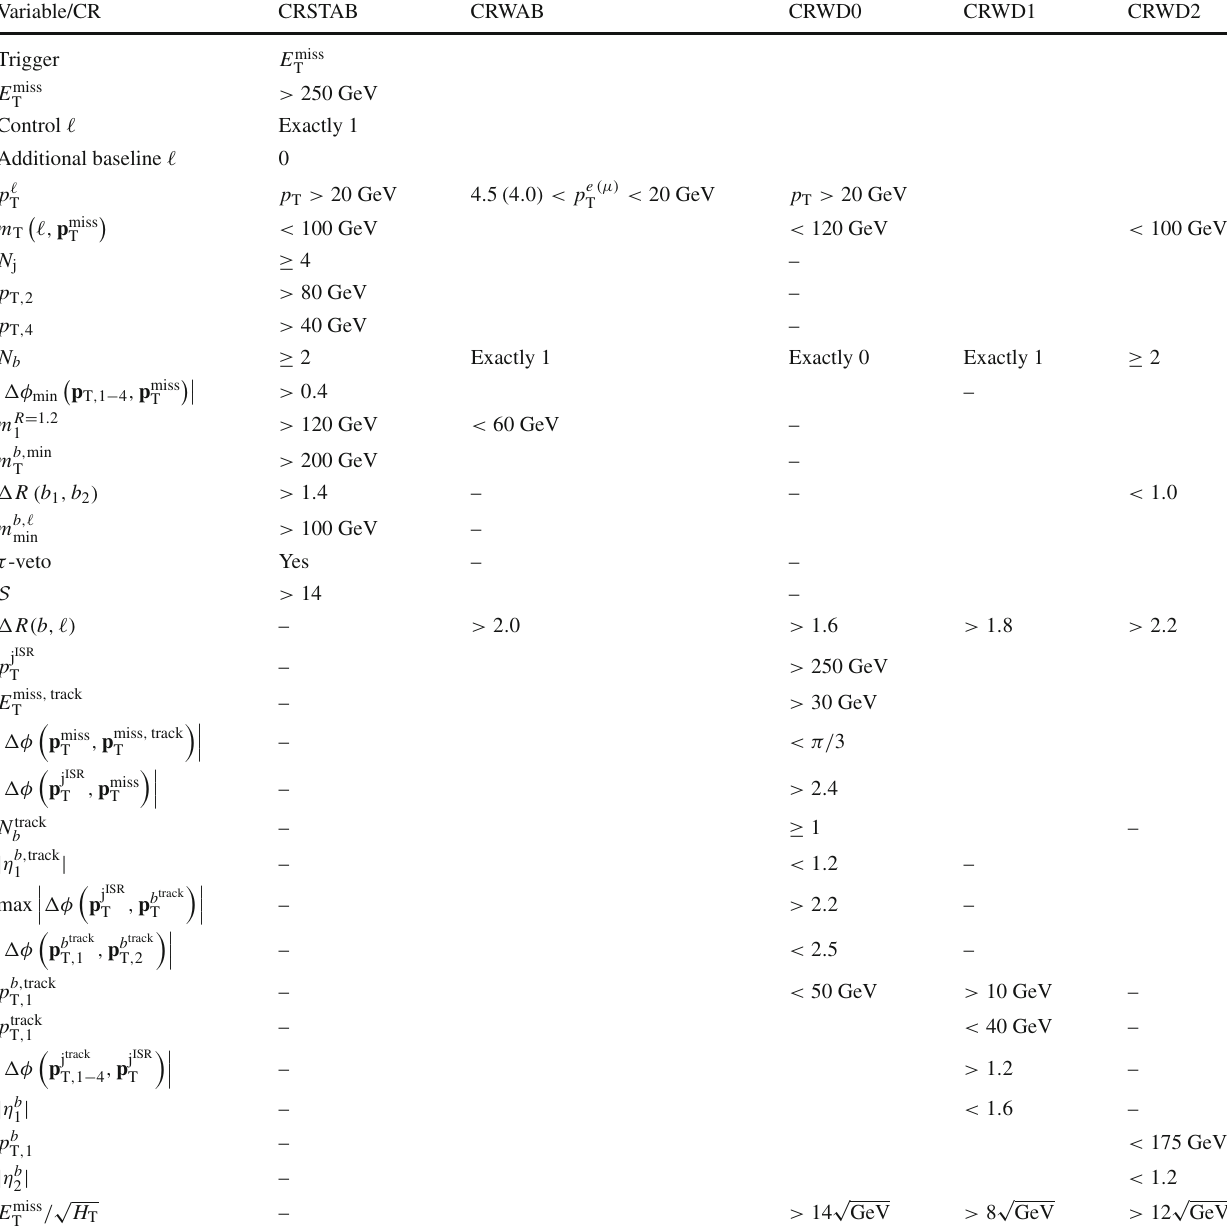
Table 8 Selection criteria for the W + jets and single-top control regions. The defining extrapolation for these control regions is over the number of leptons; one electron or muon ( (cid:13) ) from W decays is required compared with zero leptons in the signal regions. A dash indicates that noselectionisapplied. Variablesfor whichthesignalandcontrol region